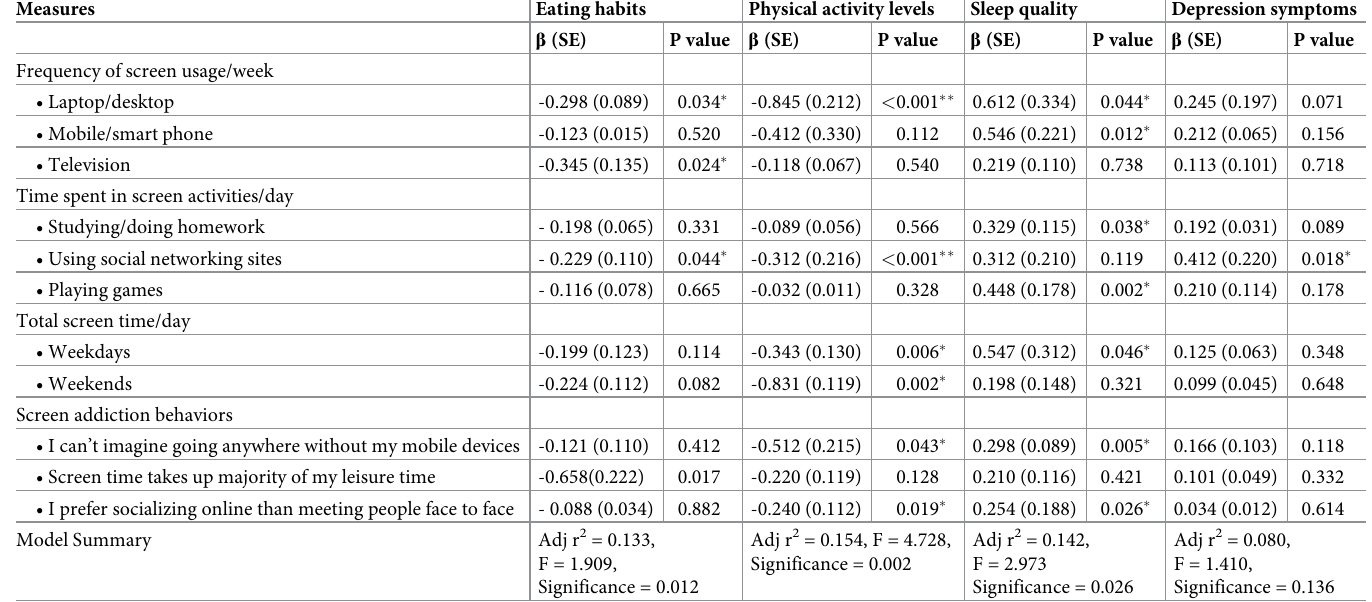
Table 4. Association of screen time during COVID-19 pandemic with eating habits, physical activity levels, sleep quality, and depression symptoms of 10–15 years old adolescents in Mumbai, India.